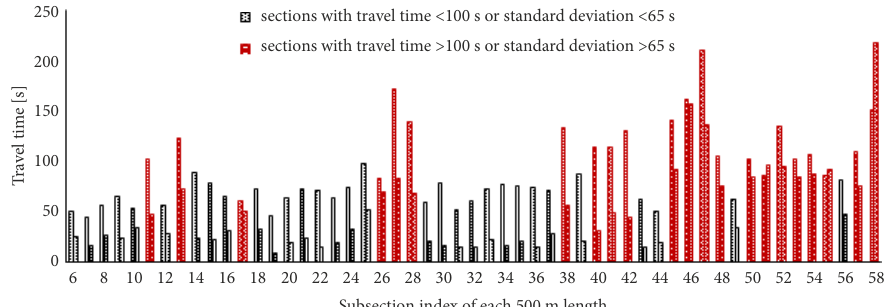
Subsection index of each 500 m Figure 9. Variation of mean and std. deviation of travel time for various sections in rainy days